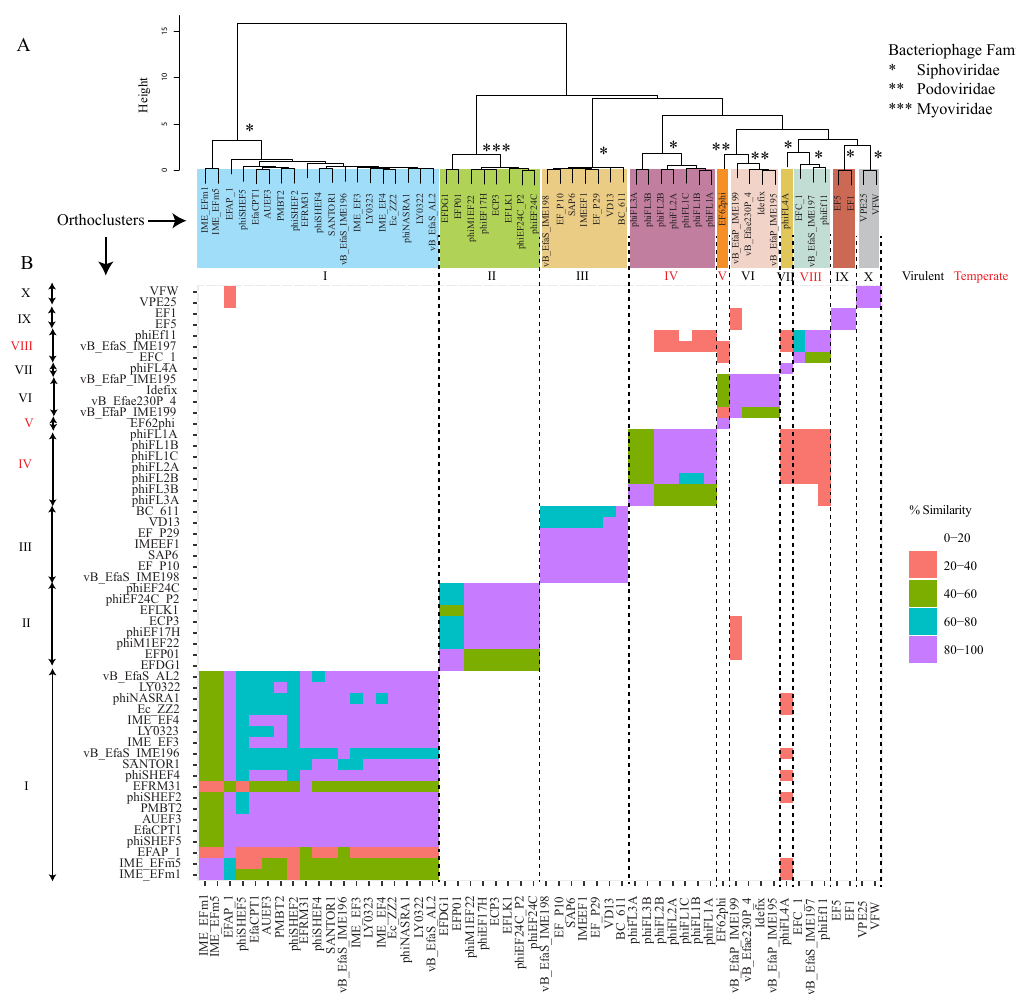
Figure 1. Genomic comparison of Enterococcus phages. ( A ) Neighbor-joining tree based on the percentage of shared orthologous genes (1000 bootstrap replicates); squares indicate the 10 phage putative orthoclusters. ( B ) Dot plot comparison of amino acids identity among the 10 orthoclusters; genes that share more than 40% homology were considered as being part of the same orthologous group. The vertical axis shows phage clusters and phage